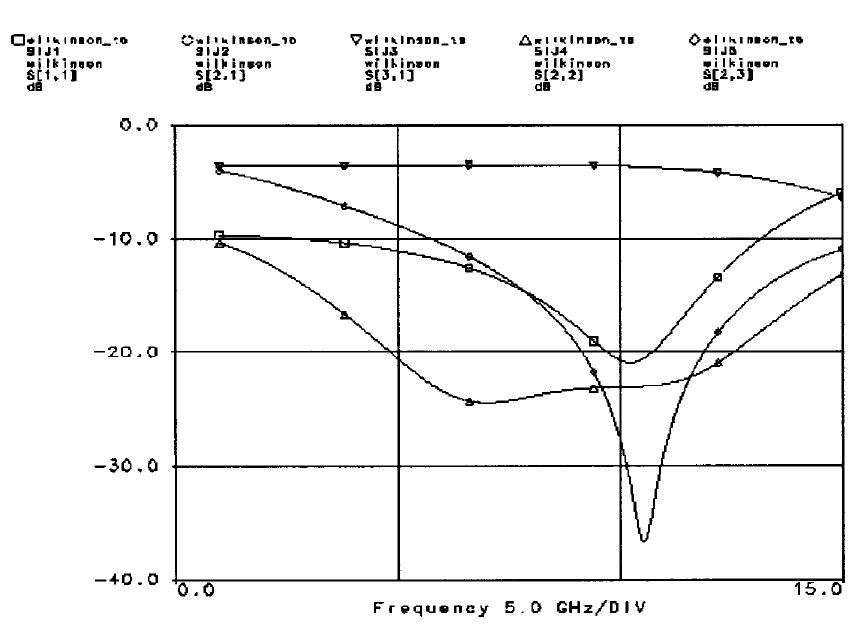
FIGURE 7 Wilkinson combiner’s s -parameters vs. frequency.